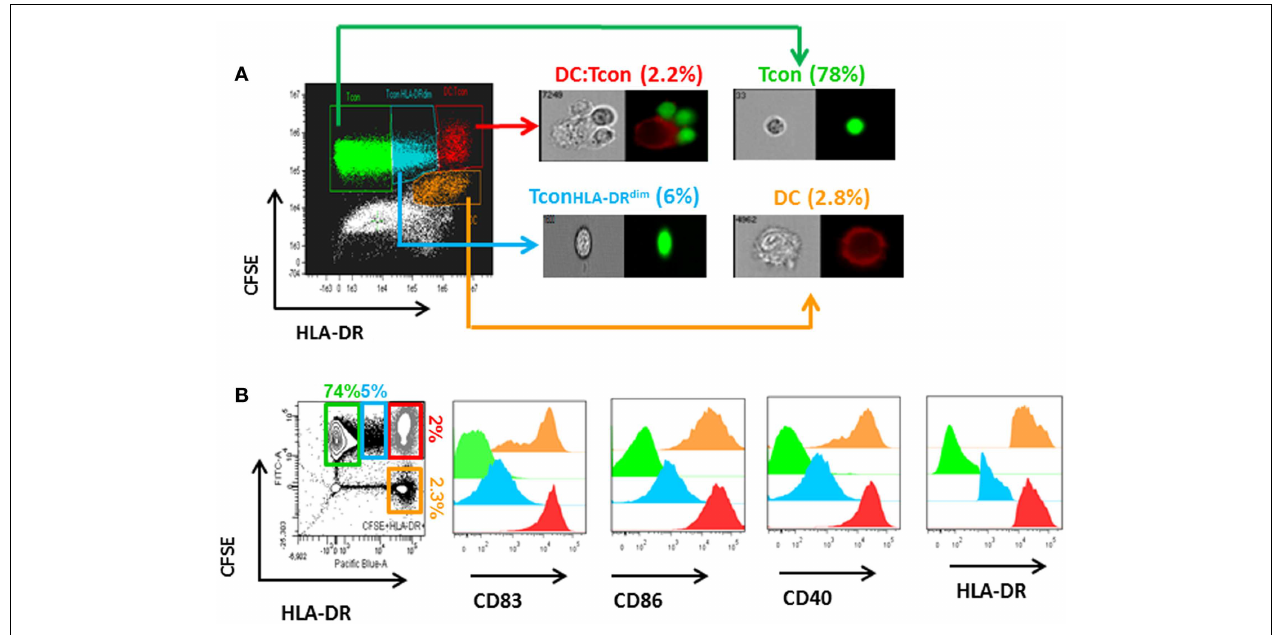
and isolated DC are CFSE-HLADR + (orange gate) populations. DC:Tcon clusters were found only in the CFSE + LADR + population. (B) Flow cytometry analysis of CD83, CD86, CD40, and HLA-DR expression in isolatedTcon (CFSE + HLADR − ; green histograms), isolated semi activated Tcon (CFSE + HLADR dim ; blue histograms), DC:Tcon (CFSE + HLADR + ; red histograms), and isolated DC (CFSE − HLADR + ; orange histograms)